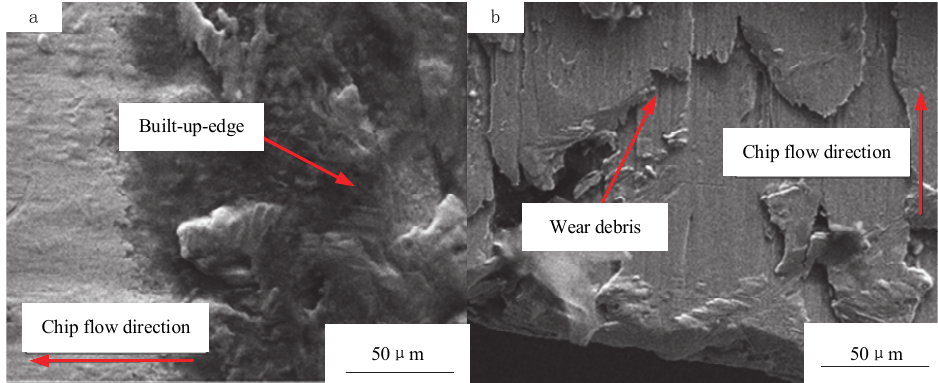
Figure 5. SEM micrographs of tool adhesion wear at low cutting speed (v c = 20 m/min): ( a ) built-up-edge; ( b ) wear debris [21].